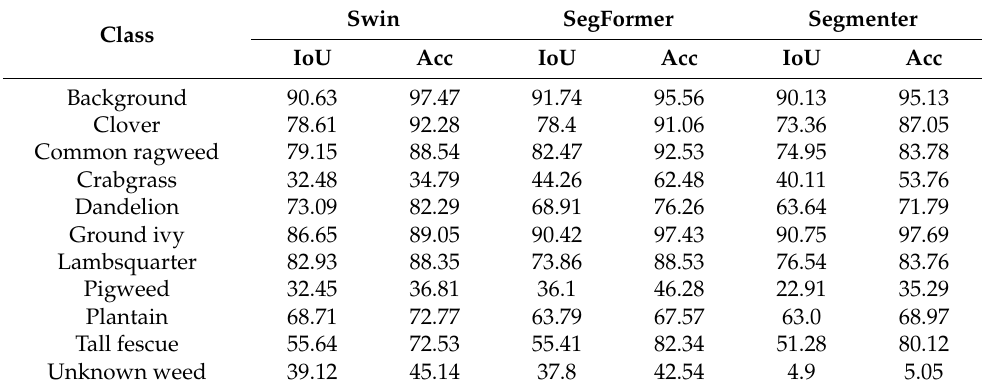
Table 3. Experimental